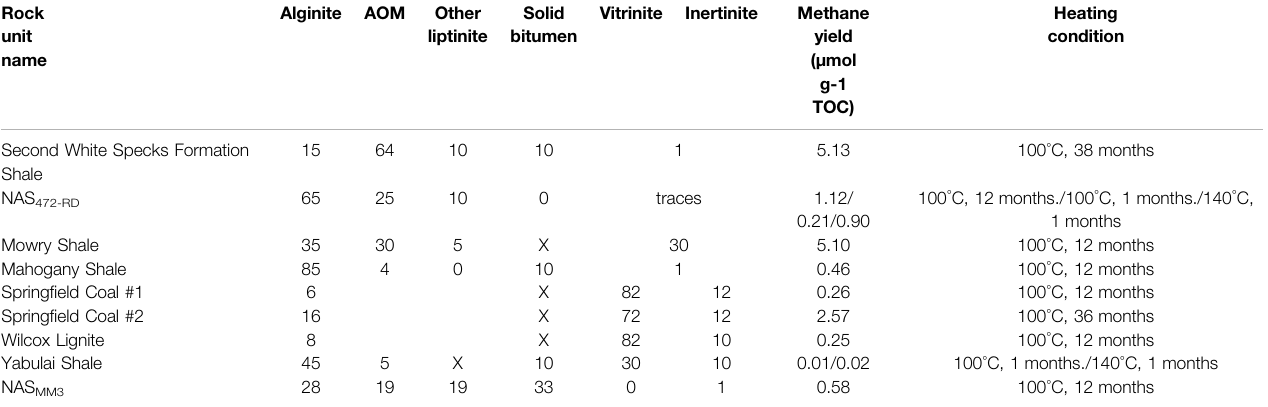
TABLE 4 | Organic petrography composition (volume %, on mineral matter free basis), methane yield, and related heating conditions of shale and coal samples. Rock